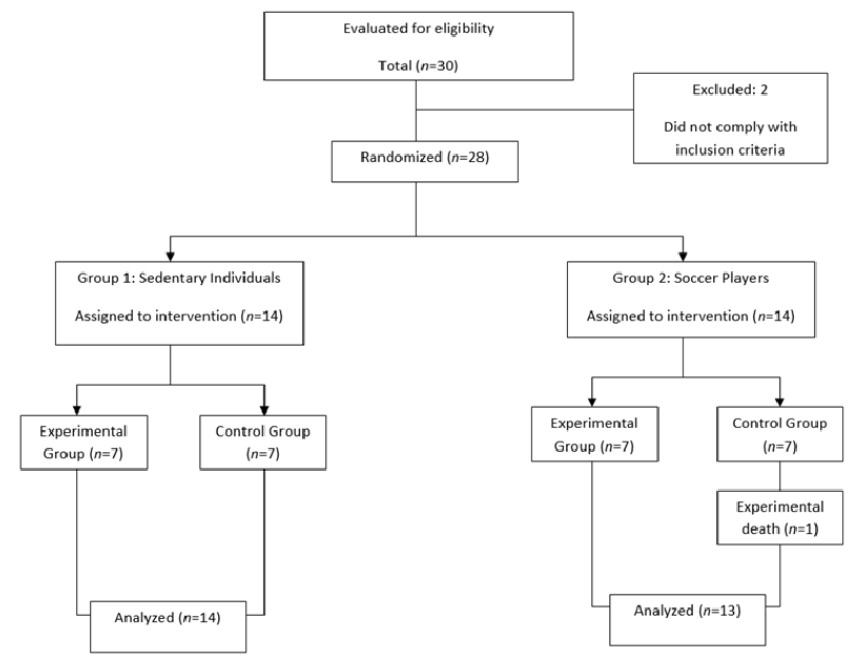
Figure 1. Flow chart of participants’ eligibility.